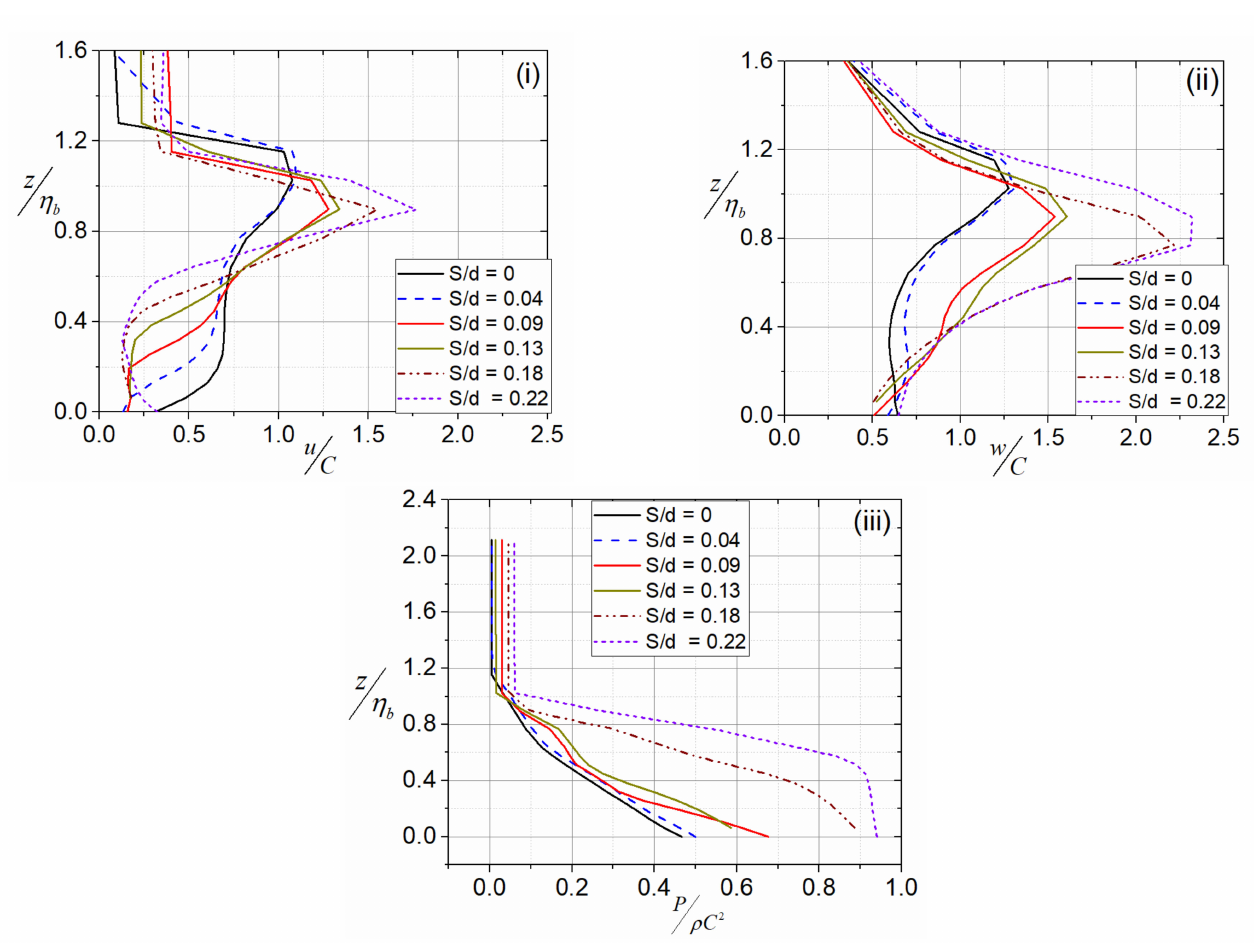
Figure 14. The variation of normalized wave parameters ( i ) horizontal velocity ( ii ) vertical velocity and ( iii ) pressure variation from SWL for different normalized airgaps ( S/d = 0, 0.04, 0.09, 0.13, 0.18, 0.22) for